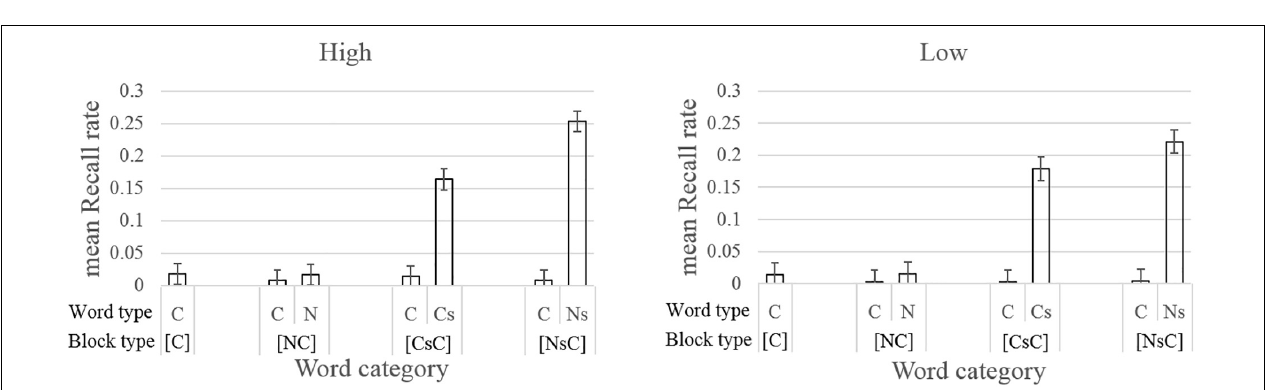
FIGURE 3 | Showing the reversed sequential modulation effects within block [CsC] (trial CsCs vs. trial CCs) and block [NsC] (trial NsNs vs. trial CNs) for high and low trait anxiety group. Error bars represent 95% confidence interval for the paired difference between two means, computed separately for the effects within block [CsC] and block [NsC] (Pfister and Janczyk, 2013). C, neutral word; N, negative word; s, word is studied.